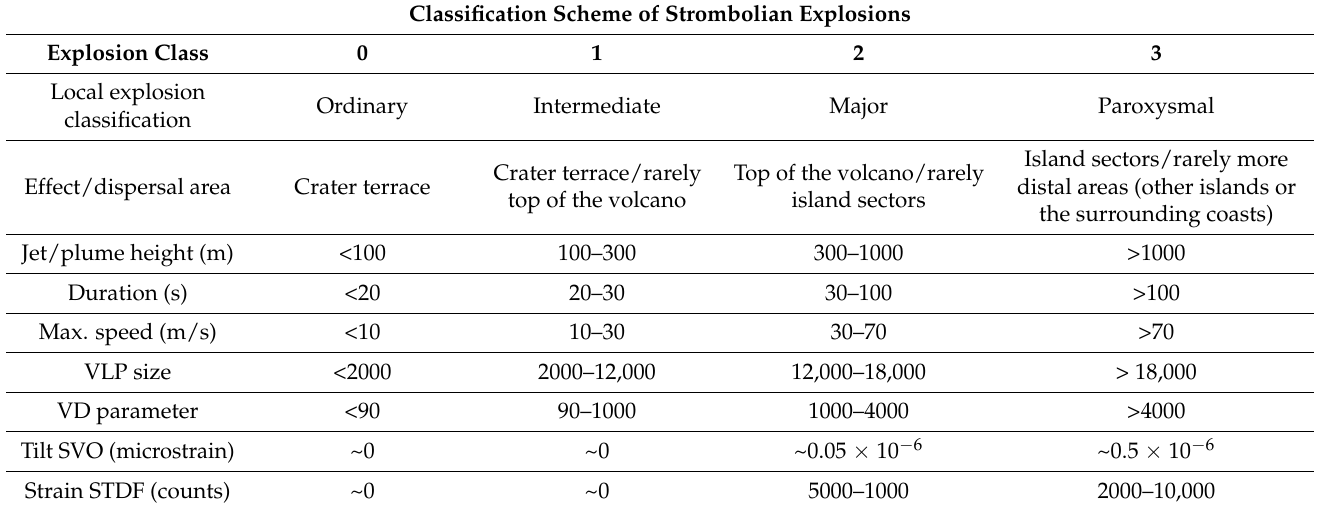
Table 5. Range of the main parameters useful to classify the explosive events of Stromboli.